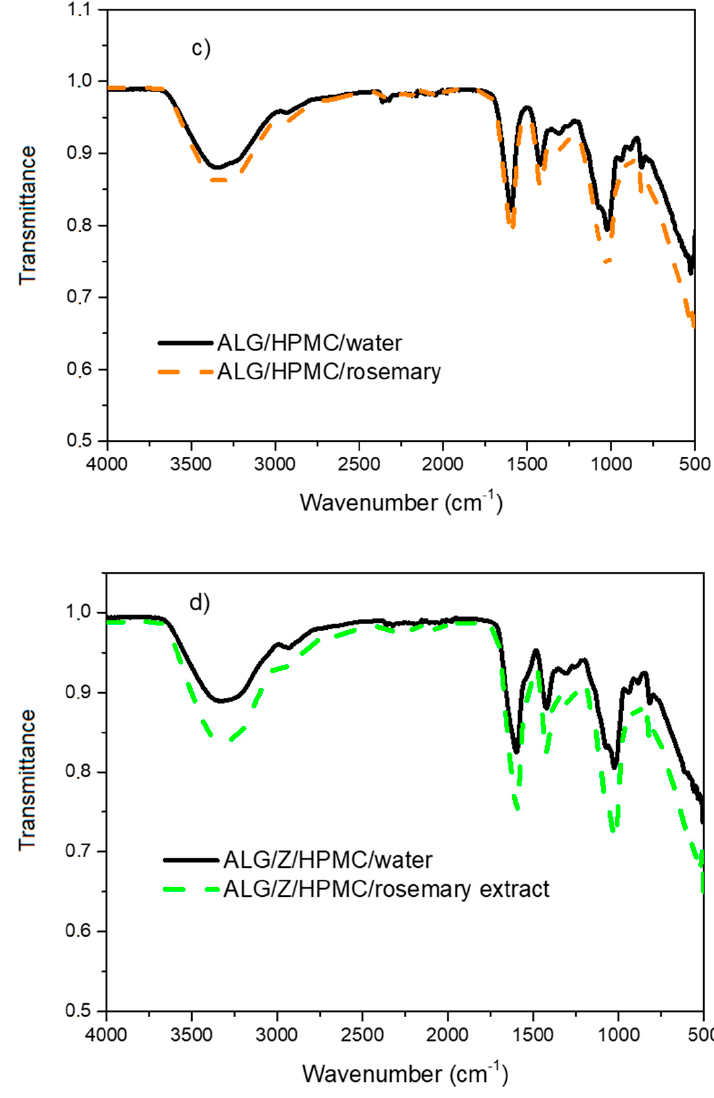
Figure 7. FTIR spectra of microparticles loaded with distilled water and rosemary extracts: ( a ) ALG/water—black line, ALG/rosemary extract—blue line; ( b ) ALG/Z/water—black line, ALG/Z/rosemary extract—red line; ( c ) ALG/HPMC/water—black line, ALG/HPMC/rosemary extract; ( d ) ALG/ZHPMC/rosemary extract—green line.